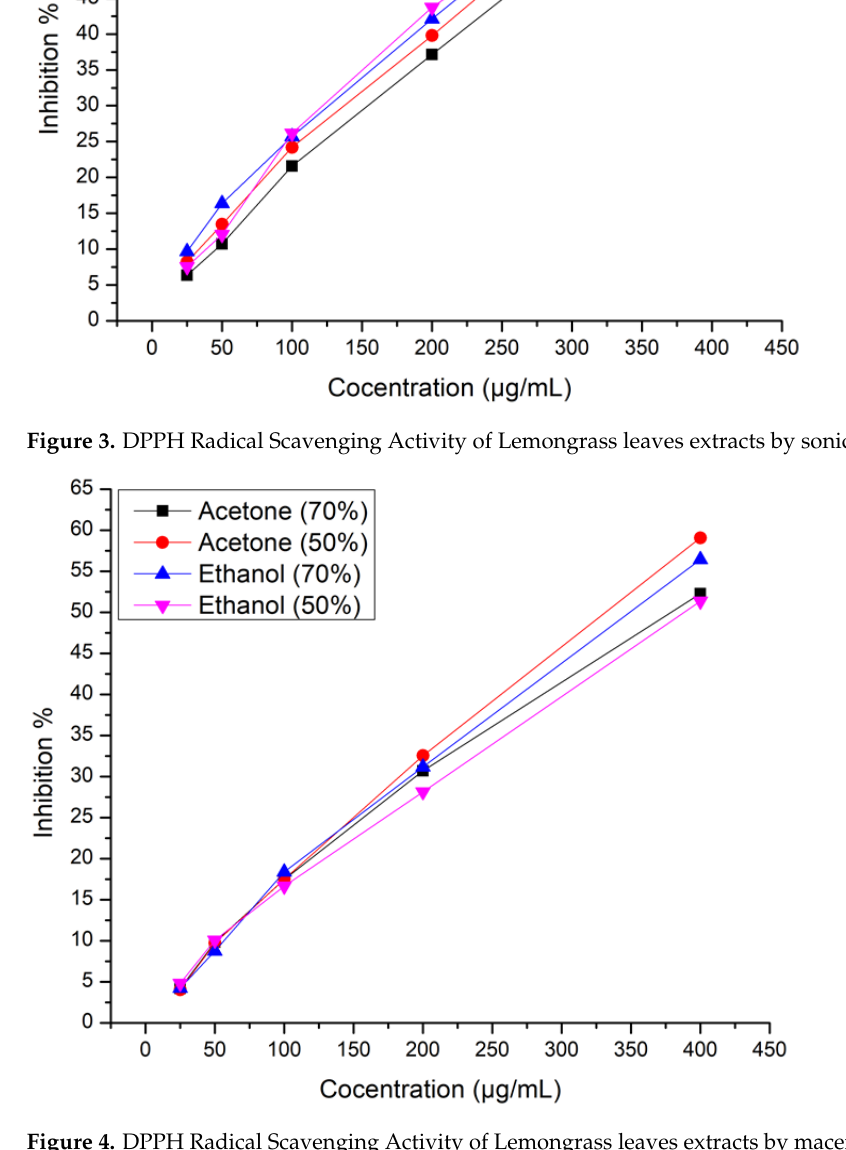
Figure 4. DPPH Radical Scavenging Activity of Lemongrass leaves extracts by maceration tech- nique.